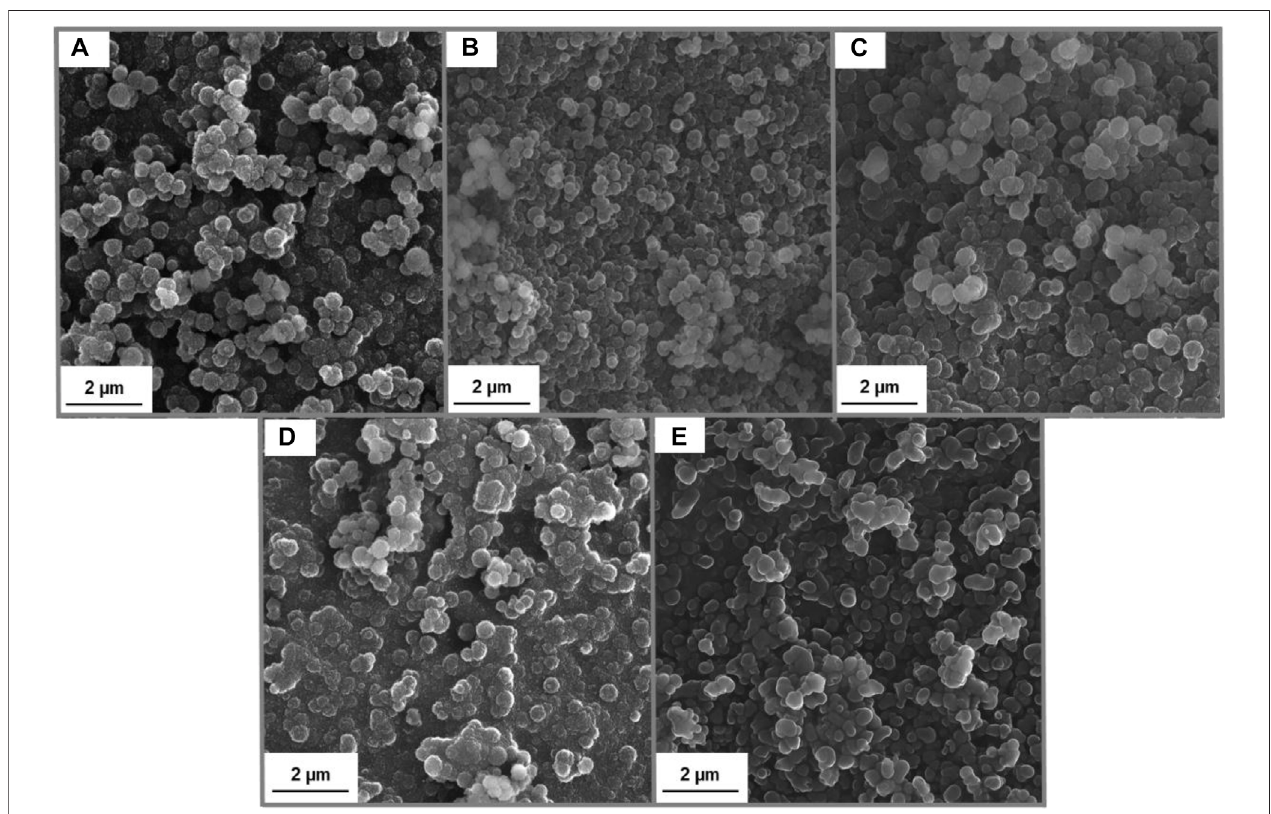
FIGURE 2 | SEM images of Lig-IL (1:1) (A) , Lig-IL (4:3) (B) , Lig-IL (2:1) (C) , Lig-IL (4:1) (D) , and Lig-IL (10:1) (E) .